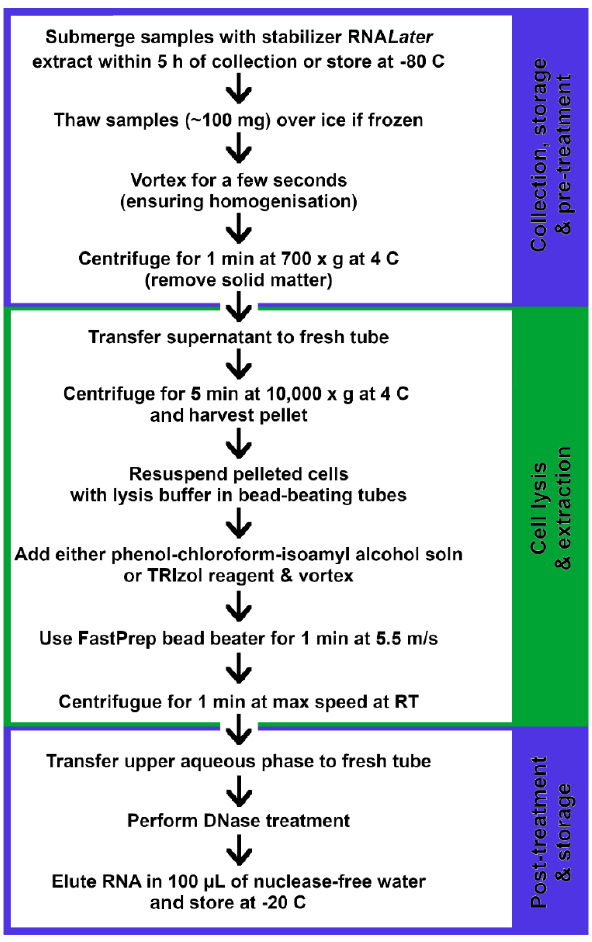
Figure 2. A combination summary of the most efficient methods in extracting mRNA products from fecal specimens.